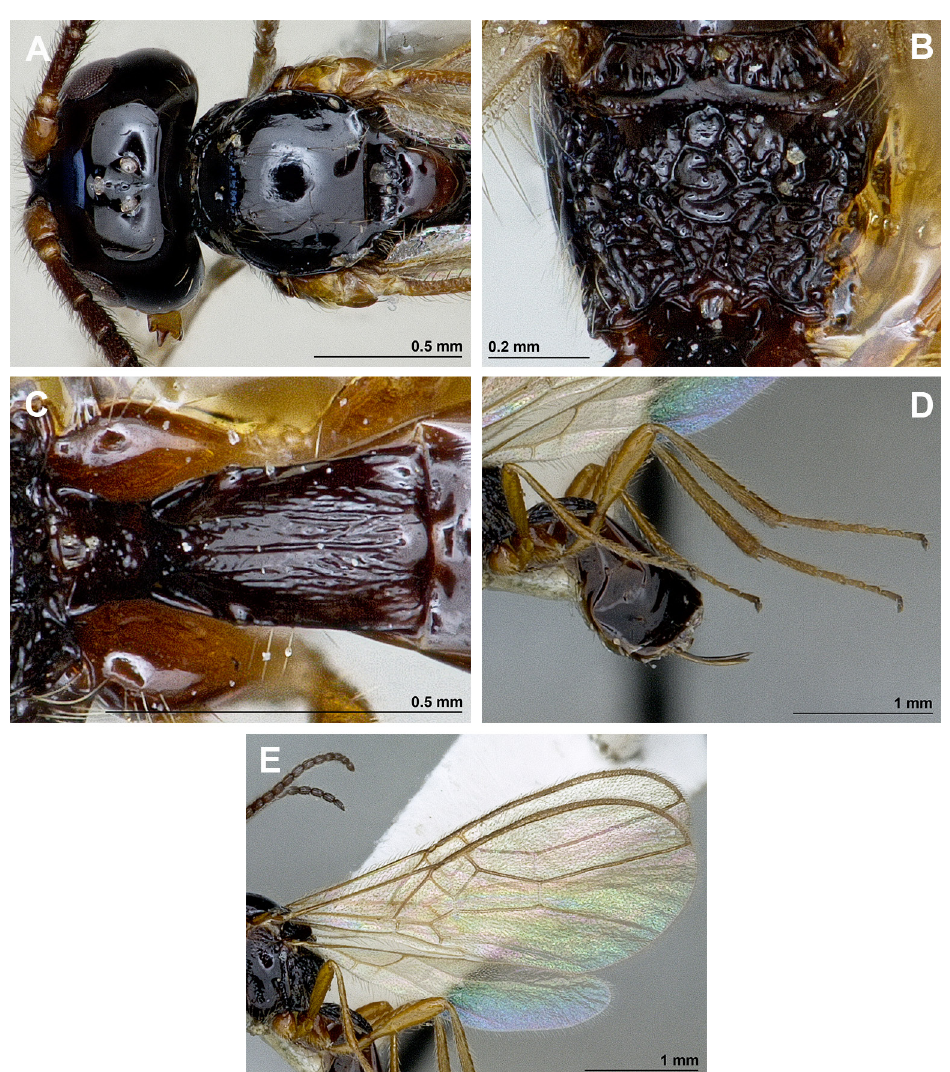
Fig. 3. Aspilota grandis Munk & Peris-Felipo sp. nov. (♀). A . Head and mesonotum, dorsal view. B . Propodeum, dorsal view. C . First metasomal tergite, dorsal view. D . Hind leg, metasoma and ovipositor. E . Fore and hind